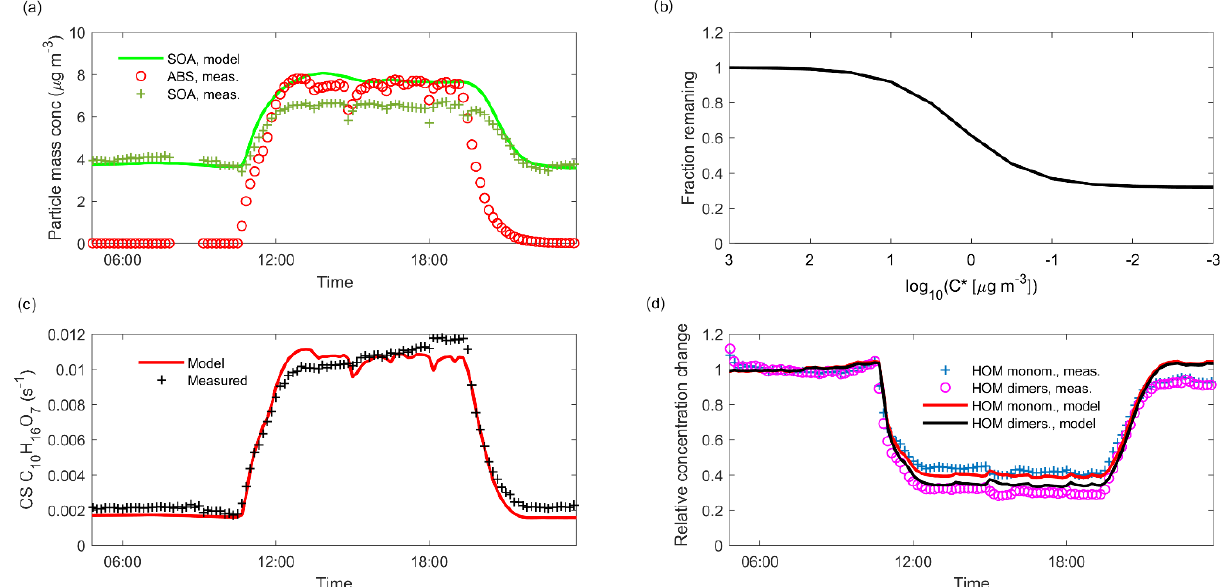
Figure A2. Experiment 3 modelled with ADCHAM. (a) the measured and modelled ABS and organic aerosol concentrations. (b) the modelled fraction remaining as a function of saturation vapour concentration. (c) modelled and measured CS for a compound with molecular formula C 10 H 16 O 7 . (d) modelled and measured relative change in the concentration of HOM monomers and dimers. The measured HOM monomers and dimer are represented by the total concentration of molecules in the mass range 290–450 and 452–600Da (including the NO −